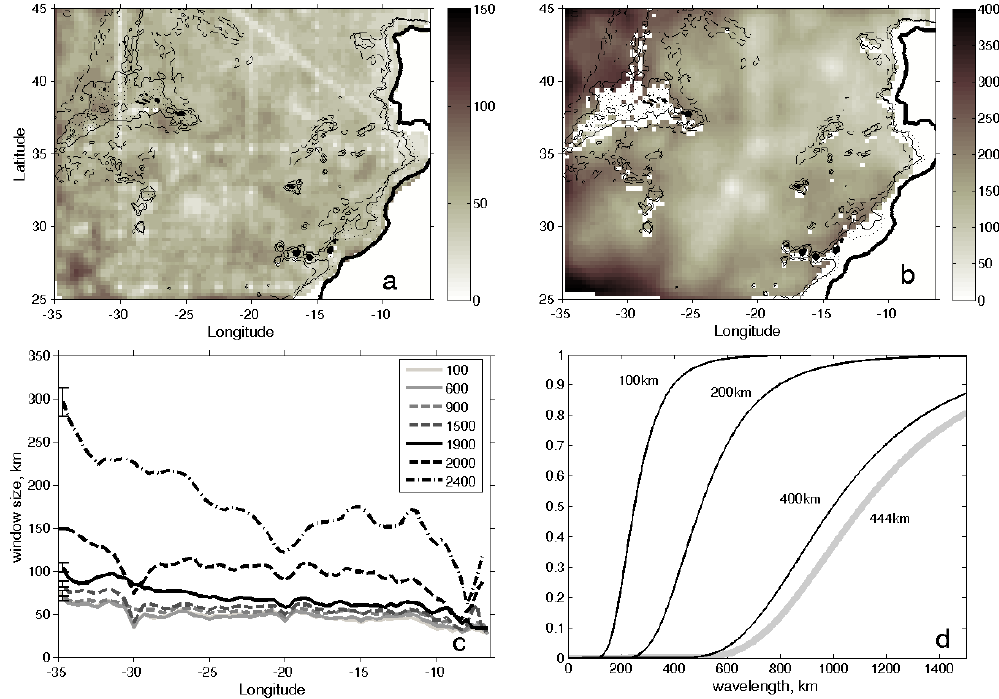
Figure 3. Radius (km) of the window containing a minimum of 30 data points: (a) at 100m and (b) at 2500m depth. Isolines of R = 100km (solid), 200km (dashed), 300km (dash–dotted) and 400km (dotted) are shown. (c) Variation of the window size as a function of the distance from the coast and water level. (d) Barnes response function for different radii of the window after the third iteration.